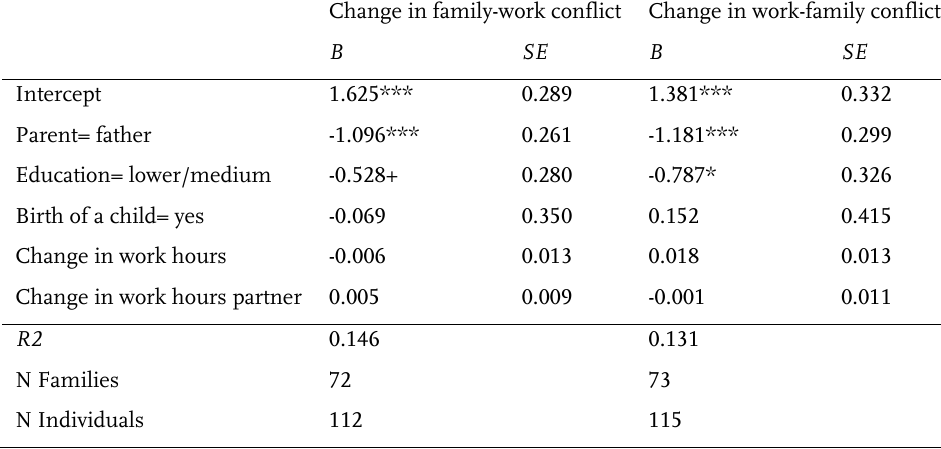
Table 2 : Multilevel regression model on change in F → W-conflict and W → F-conflict Change in family-work conflict Change in work-family